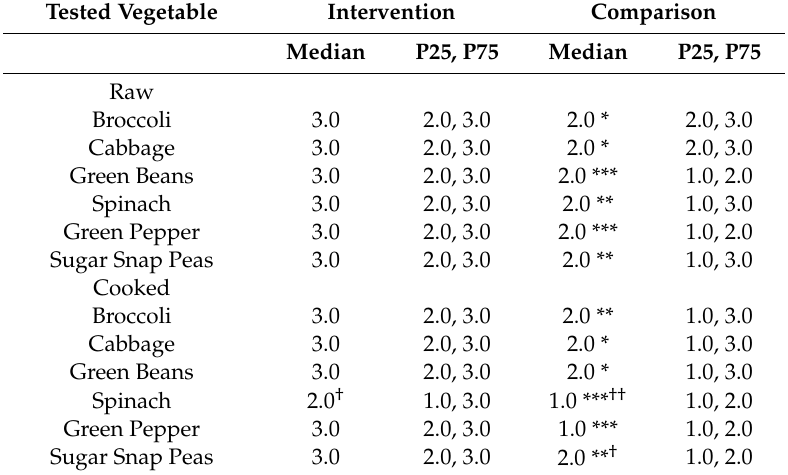
Table 3. Individual vegetable scores from green vegetable tasting party for intervention and comparison group. Tested